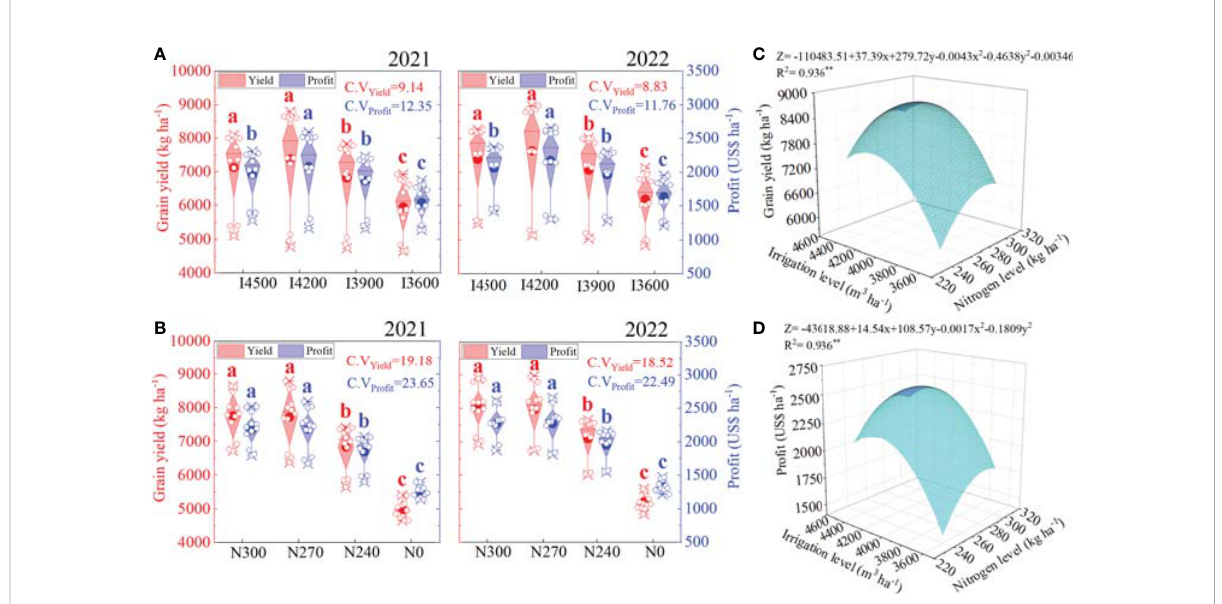
FIGURE 2 Effects of irrigation and nitrogen levels on wheat yield and economic bene fi ts. (A, B) represent the effect of irrigation and nitrogen on yield and pro fi t, respectively; (C, D) represents the combined effect of irrigation and nitrogen on yield and pro fi t, respectively. I4500, I4200, I3900, and I3600 indicate 4500, 4200, 3900, and 3600 m 3 ha − 1 irrigation levels, respectively. N300, N270, N240, and N0 indicate 300, 270, 240, and 0 kg ha − 1 nitrogen levels, respectively. C.V Yield and C.V Pro fi t indicate the coef fi cient of variation in grain yield and pro fi t among the irrigation and nitrogen levels, respectively. The lowercase letters refer to signi fi cant differences among the treatments at the 0.05